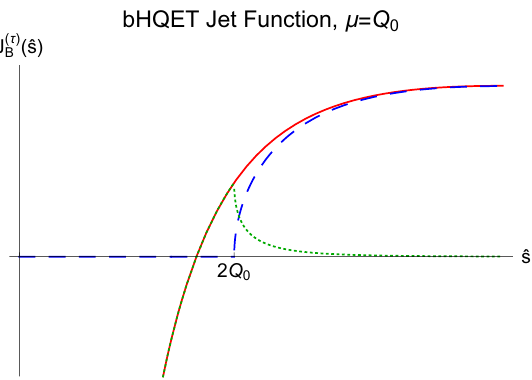
Figure 6. bHQET jet function without cut (solid red), unreleased (dotted green) and with cut (dashed blue) for (cid:22) = Q 0